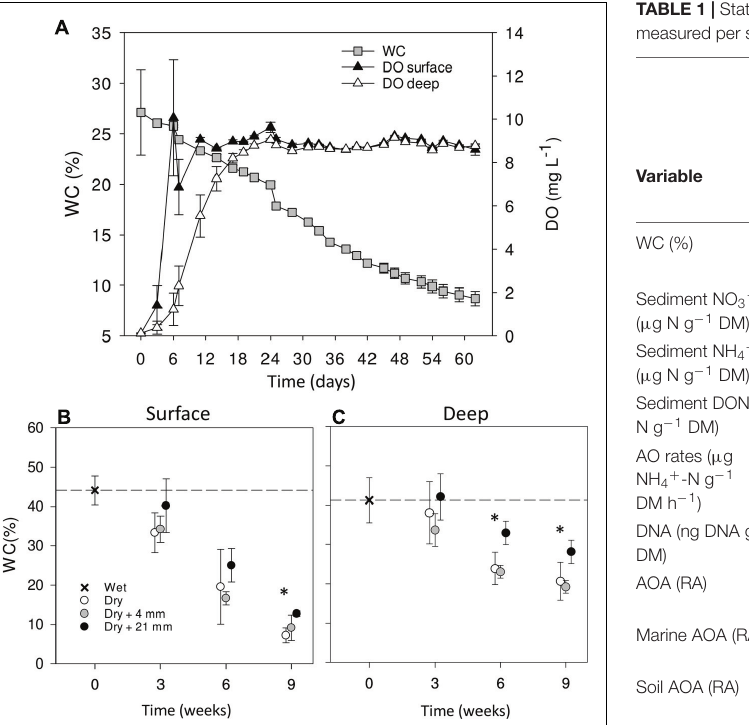
FIGURE 1 | Mean ( ± SE, n = 9) WC and DO concentration in surface and deep sediments monitored over the entire experiment in dry microcosms with no rainfall application (A) . Mean WC ( ± SE, n = 3) in surface (B) and deep (C) sediments during initial conditions (0 weeks) and after the different RMs for each DPD. Asterisks ( ∗ ) denote significant ( P ≤ 0.05) differences to initial wet conditions after Student’s t -test followed by Holm’s correction for multiple comparisons. The dashed line represents the initial conditions as a reference for a better comparison.